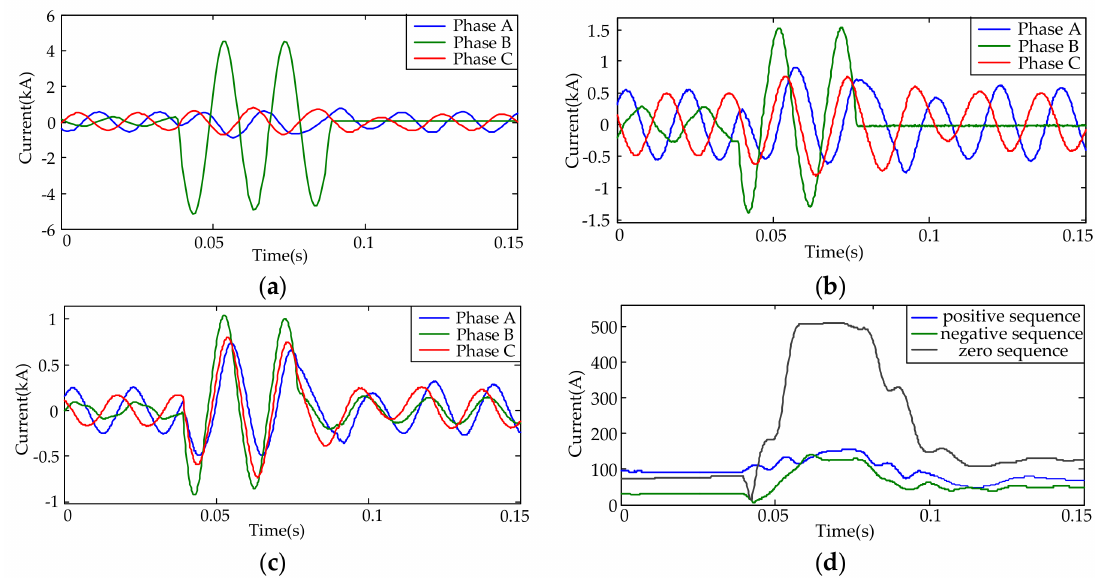
Figure 5. The real fault waveform records when a phase B ground fault occurs on the transmission line connected to a DFIG-based wind farm with LVRT capability: ( a ) currents of the grid side; ( b ) currents of the wind farm side; ( c ) currents of the transformer T 2 ; and ( d ) Root-Mean-Square (RMS) current values of the transformer T 2